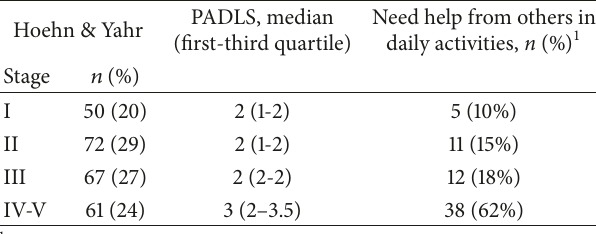
Table 4: Descriptive data of Parkinson’s disease Activities of Daily Living Scale (PADLS) scores across Hoehn & Yahr